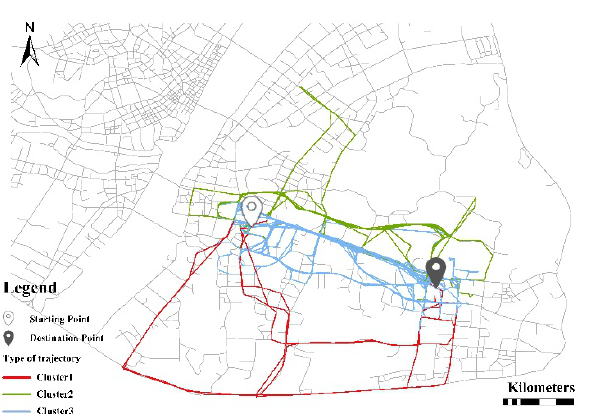
Figure9: The clustering results of the trajectories from Wuchang Railway Station to Guanggu Square.